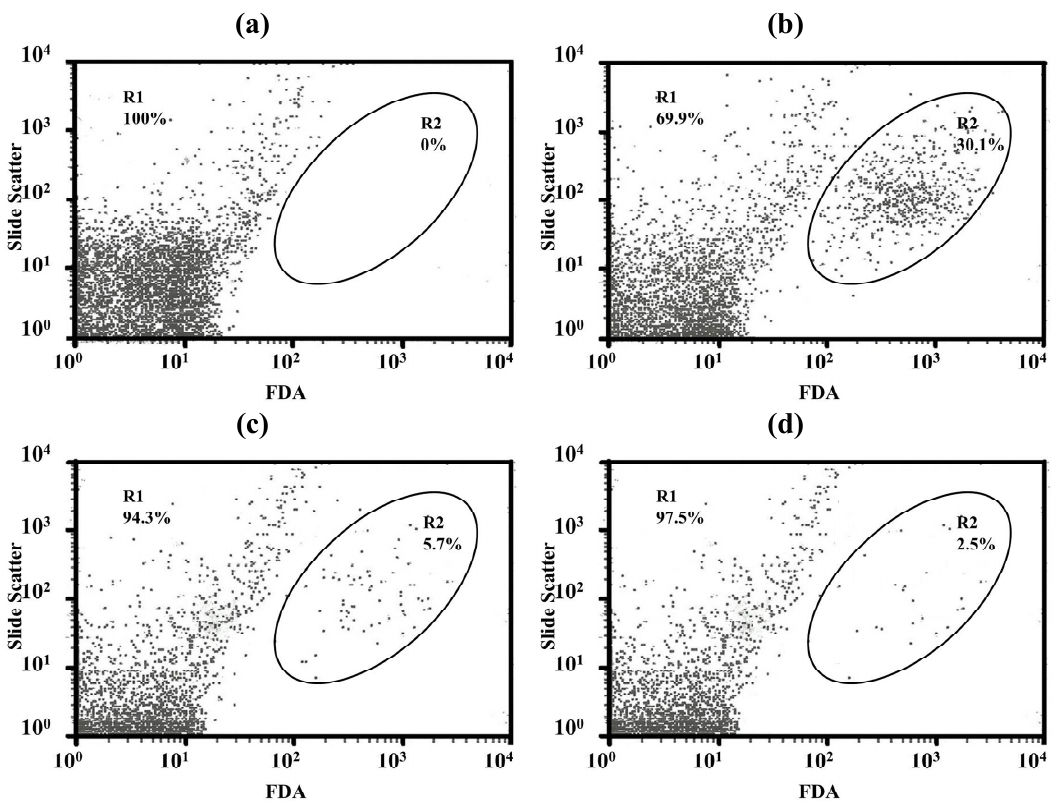
( c ) 5 days; ( d ) 7 days and then stained with